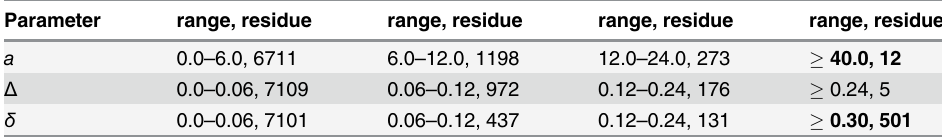
Table 2. The statistics of a , Δ and δ . The data are obtained from a set of the DSSP assigned α -helices on a set of 382 ultra-high resolution ( (cid:1) 1.0 Å ) x-ray structures. Each column presents respectively a data range and the number of residues inside that range. Both RMSDs, Δ and δ , have unit Å while a is in degree.